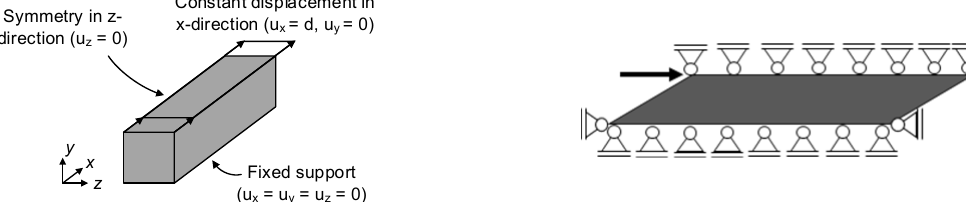
Fig. 19 Applied boundary conditions for the numerical model. Only the silicone sealant is modelled due to the high rigidity of the adherends compared to the sealant.